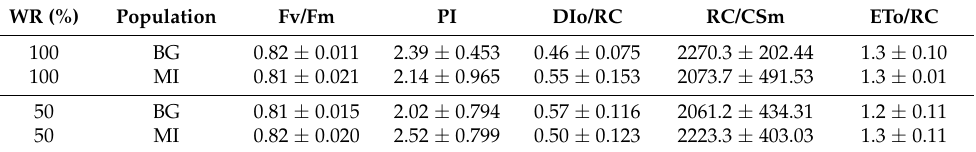
Table 1. Water reduction (WR): 100% water availability and 50% water reduction and its effect on maximum quantum efficiency (Fv/Fm), performance index (PI), dissipation of energy across reac- tion centers (DIo/RC), reaction centers per cross-section at Fm (RC/CSm), and electron flux per re- action center (ETo/RC).